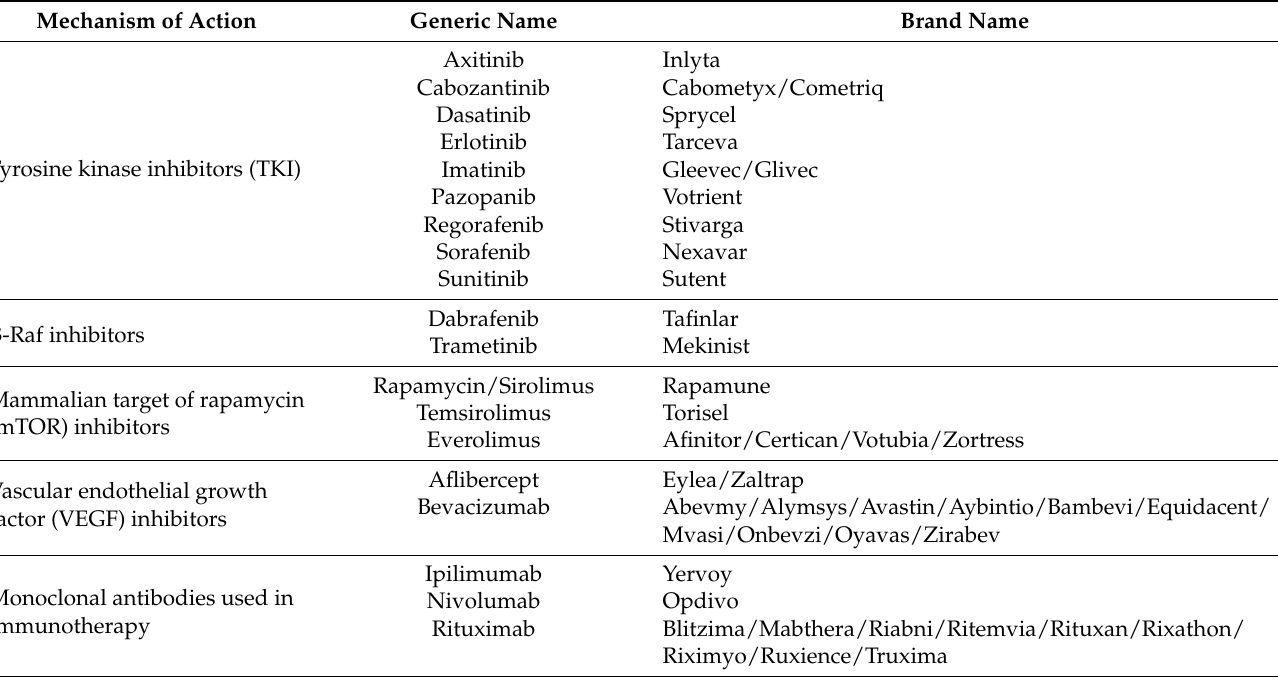
Table 2. Non-antiresorptive drugs, potential to cause